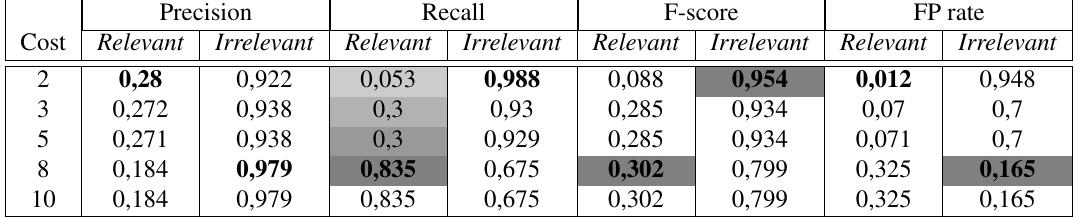
Table 9: Results of a cost-sensitive BN classifier using different cost values for category G. Precision